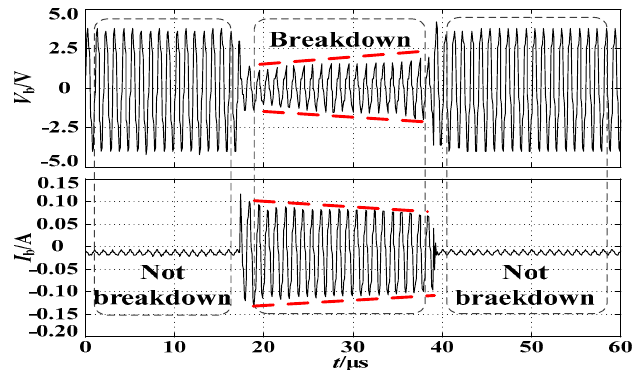
Figure 3. The test point display.